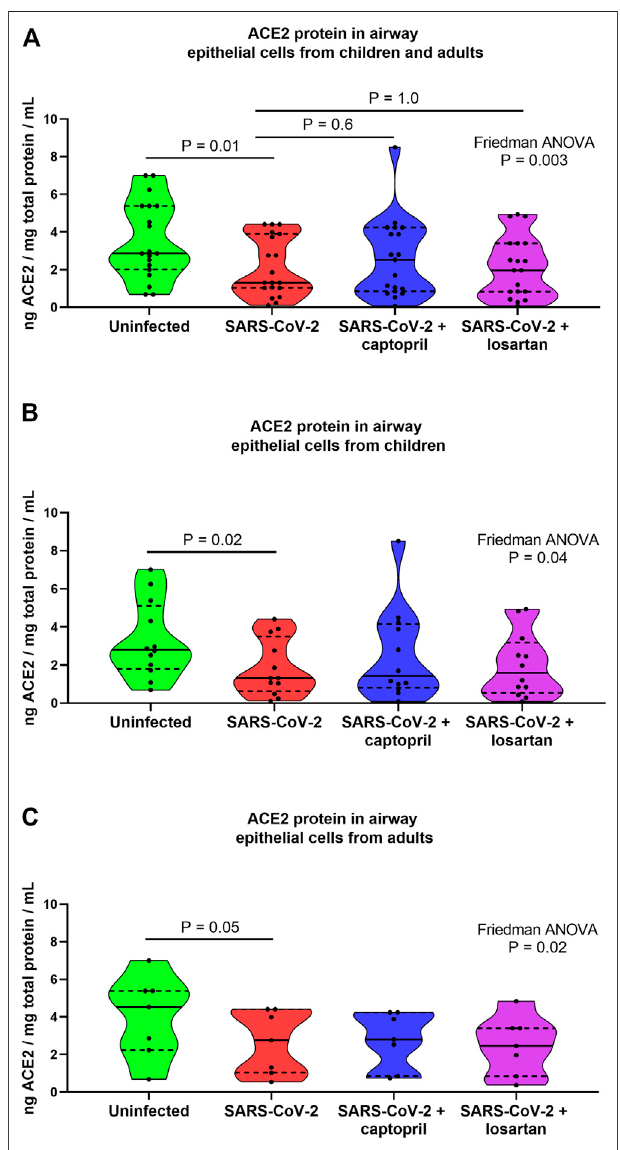
FIGURE3| ACE2proteinconcentrationsincelllysatesfromorganotypic bronchial airway epithelial cell cultures from children ( n (cid:1) 12) and older adults ( n (cid:1) 7). ACE2 concentrationswerenormalizedto totalprotein concentration in cell lysates. ACE2 protein concentrations were 2.2-fold lower in SARS- CoV-2 infected cultures as compared to uninfected cultures [ (A) children and adults combined, n (cid:1) 19; Friedman ANOVA p (cid:1) 0.003; Dunn ’ s multiple comparison test for uninfected vs. SARS-CoV-2 infected cultures p (cid:1) 0.01], however, ACE2 protein concentrations were not signi fi cantly different between SARS-CoV-2 infected cultures with or without treatment with captopril or losartan. (B) presents data from children separately ( n (cid:1) 12), wherein ACE2 concentrations were 2.2-fold lower in SARS-CoV-2 infected cultures as compared to uninfected cultures (Friedman ANOVA p (cid:1) 0.04; Dunn ’ s multiple comparison test for uninfected vs. SARS-CoV-2 infected cultures p (cid:1) 0.02). ACE2 concentrations were not signi fi cantly different between SARS-CoV-2 infected cultures with or without treatment with captopril or losartan. (C) presents data from adults separately ( n (cid:1) 7), wherein